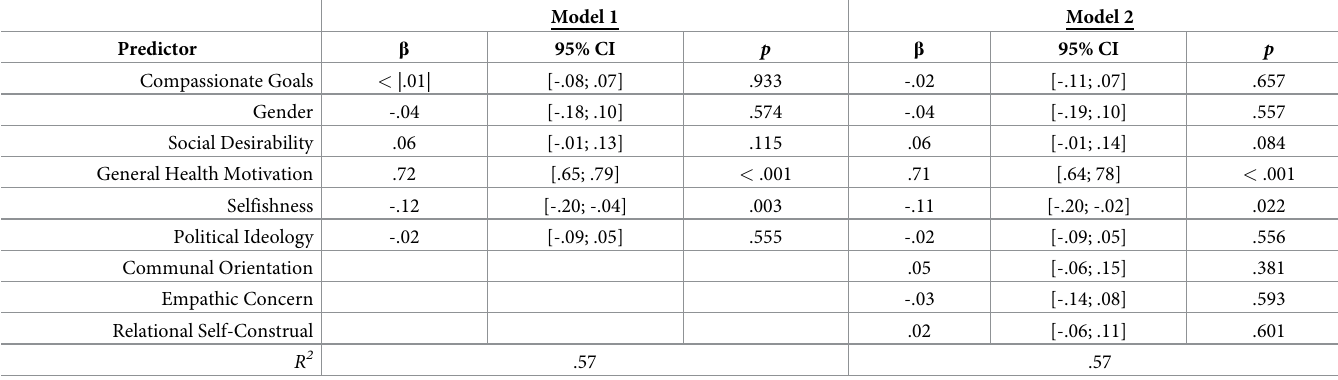
Table 12. Coefficients from multiple regression models predicting general health behaviors in Study